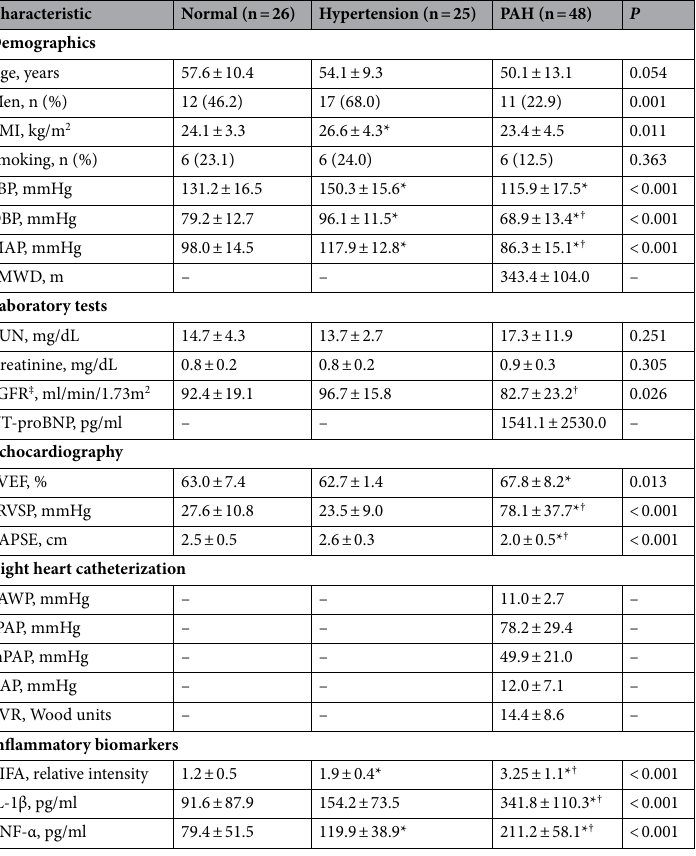
Table 1. Baseline characteristics of the study population. 6MWD, 6-min walk distance; BMI, body mass index; BUN, blood urea nitrogen; DBP, diastolic blood pressure; eGFR, estimated glomerular filtration rate; eRVSP, estimated right ventricular systolic pressure; IL-1β, interleukin-1β; LVEF, left ventricular ejection fraction; mPAP, mean pulmonary artery pressure; MAP, mean arterial pressure; NT-proBNP, N-terminal pro-B type natriuretic peptide; PAH, pulmonary arterial hypertension; PAWP, pulmonary artery wedge pressure; PVR, pulmonary vascular resistance; RAP, right atrial pressure; SBP, systolic blood pressure; sPAP, systolic pulmonary artery pressure; TAPSE, tricuspid annular plane systolic excursion; TIFA, tumor necrosis factor-α receptor-associated factor-interacting protein with a forkhead-associated domain; TNF-α, tumor necrosis factor-α. Post-hoc analysis by Bonferroni test: * P < 0.05, vs. normal; † P < 0.05, vs. hypertension. ‡ eGFR was calculated from the Modification of Diet in Renal Disease equation for